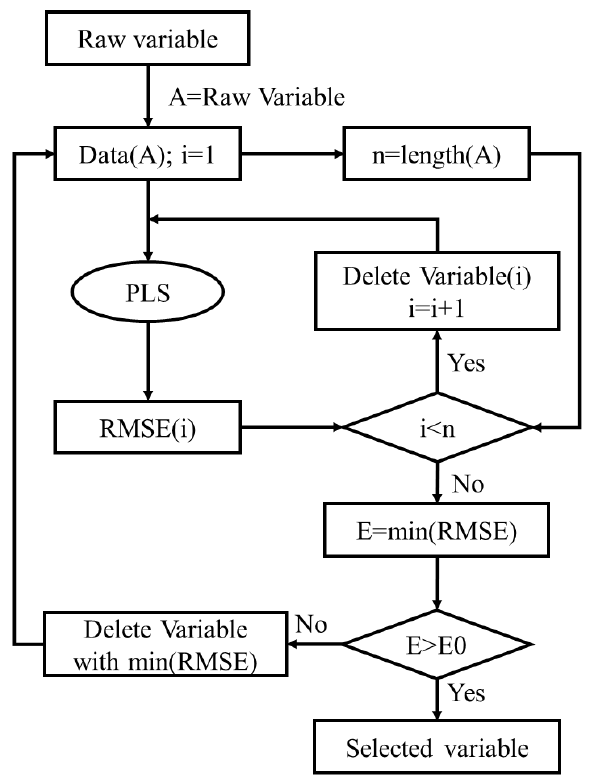
Figure 1. Flowchart of Stepwise-PLS (partial least-squares regression).